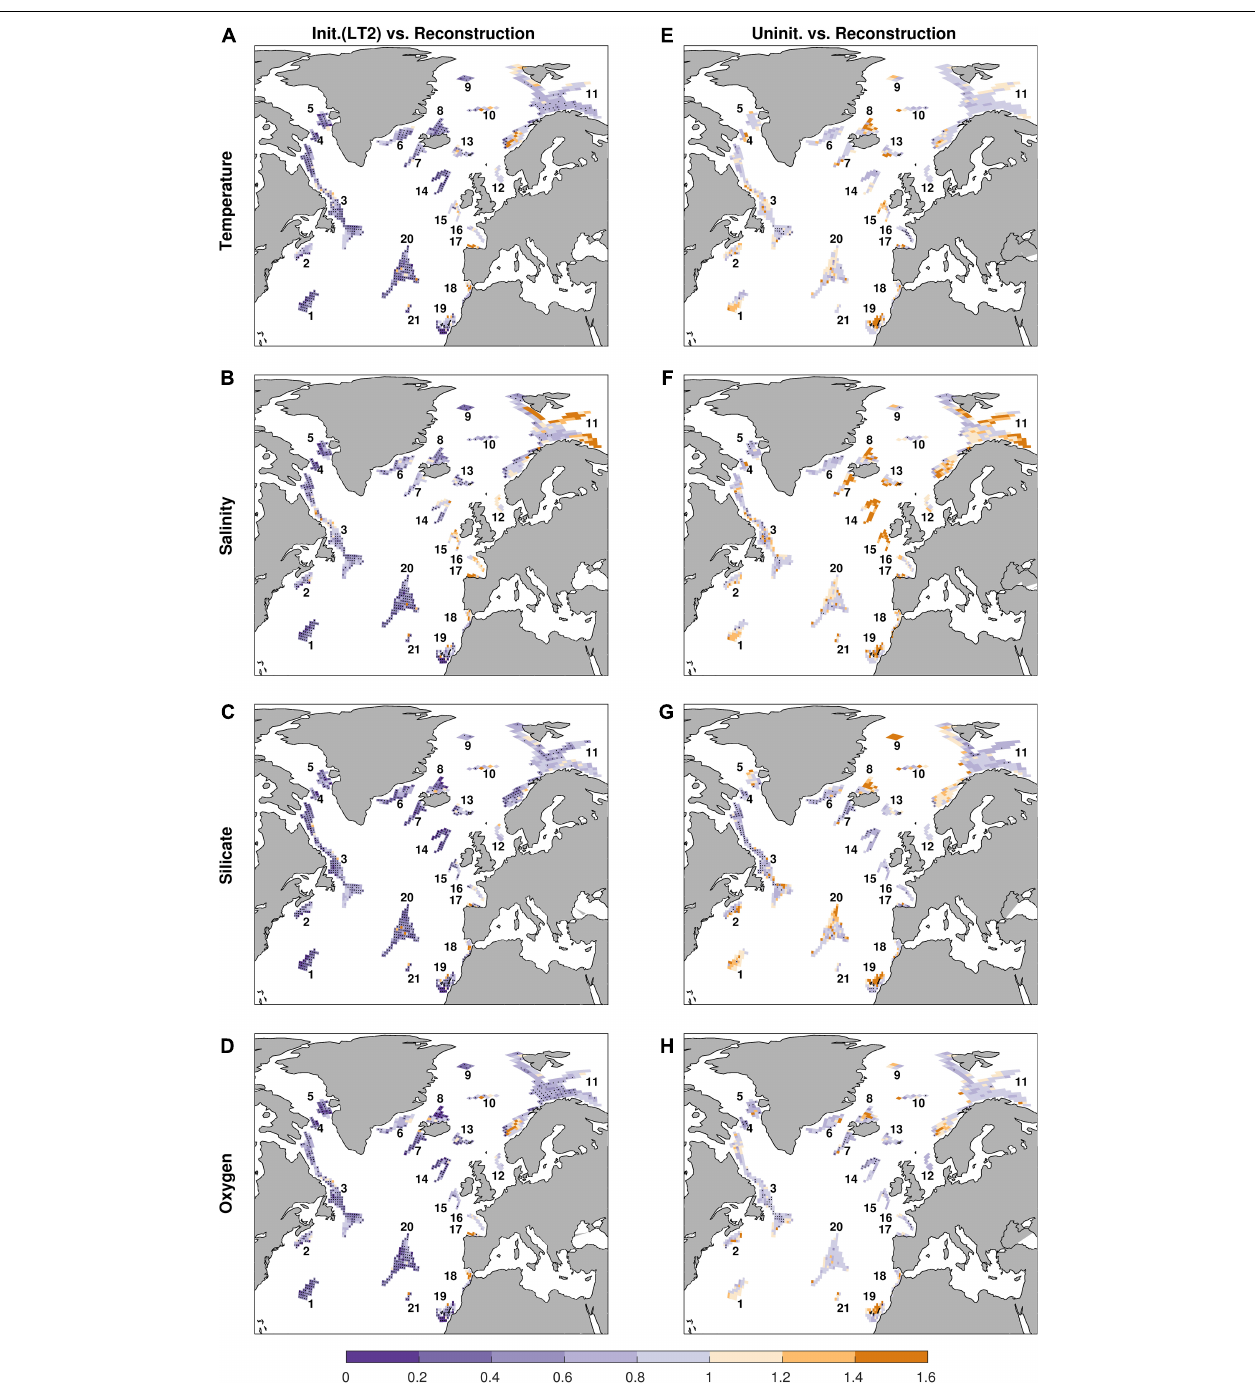
FIGURE 5 | Normalized mean absolute errors (NMAEs) for temperature (A,E) , salinity (B,F) , silicate (C,G) , and oxygen (D,H) . Left column (A–D) : NMAEs of initialized simulations at a lead time of 2 years. Right column (E–H) : NMAEs of uninitialized simulations. Stippling denotes NMAEs less than 1 at the 95% significance level based on a bootstrap approach with 500 bootstrapped